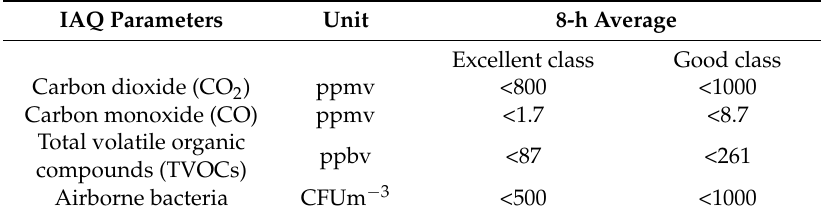
Table 1. Indoor air quality objectives in office buildings and public places in Hong Kong [21].